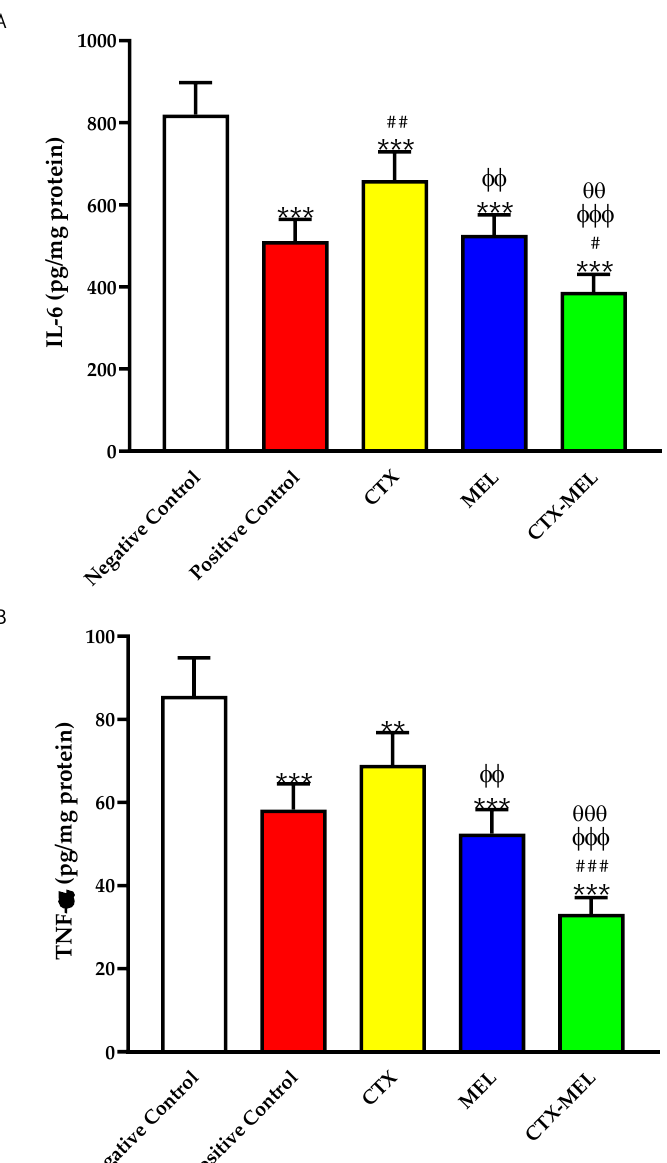
Figure 5. Effect of CTX, MEL, or CTX–MEL nanocomplex on ( A ) IL-6 and ( B ) TNF- α content in wounded skin of diabetic rats. Negative control refers to rats that received topical plain vehicle consisting of HPMC-based hydrogel (1.5% w / v ) on the wound area, while positive control refers to animals that received 0.5 g of Mebo TM ointment on the wound area. Data are expressed as mean ± SD, ( n = 6). ** Significantly different vs. negative control, p < 0.01; *** significantly different vs. negative control, p < 0.001; ## significantly different vs. positive control, p < 0.01; ### significantly different vs. positive control, p < 0.001; ϕϕ significantly different vs. CTX, p < 0.01; ϕϕϕ significantly different vs. CTX, p < 0.001; ѲѲ significantly different vs. CTX, p < 0.01; ѲѲѲ significantly different vs. CTX, p < 0.001.